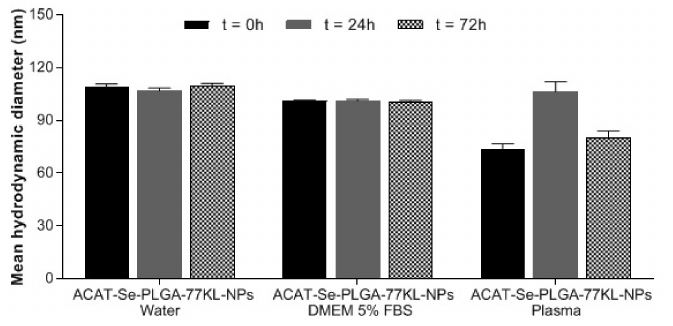
Figure 5. Mean hydrodynamic diameter of ACAT-Se-PLGA-77KL-NPs after 0, 24 and 72 h of incuba- tion with water, DMEM 5% FBS and plasma. Each value represents mean ± SE of three experiments. Statistical analyses were performed by Student t -test and no significant differences were